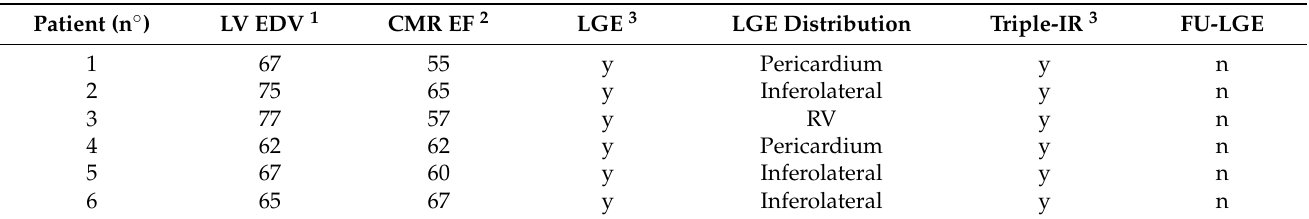
Table 2. General characteristics of patients hospitalized due to vaccine-related myocardial in- volvement at the CMR imaging.